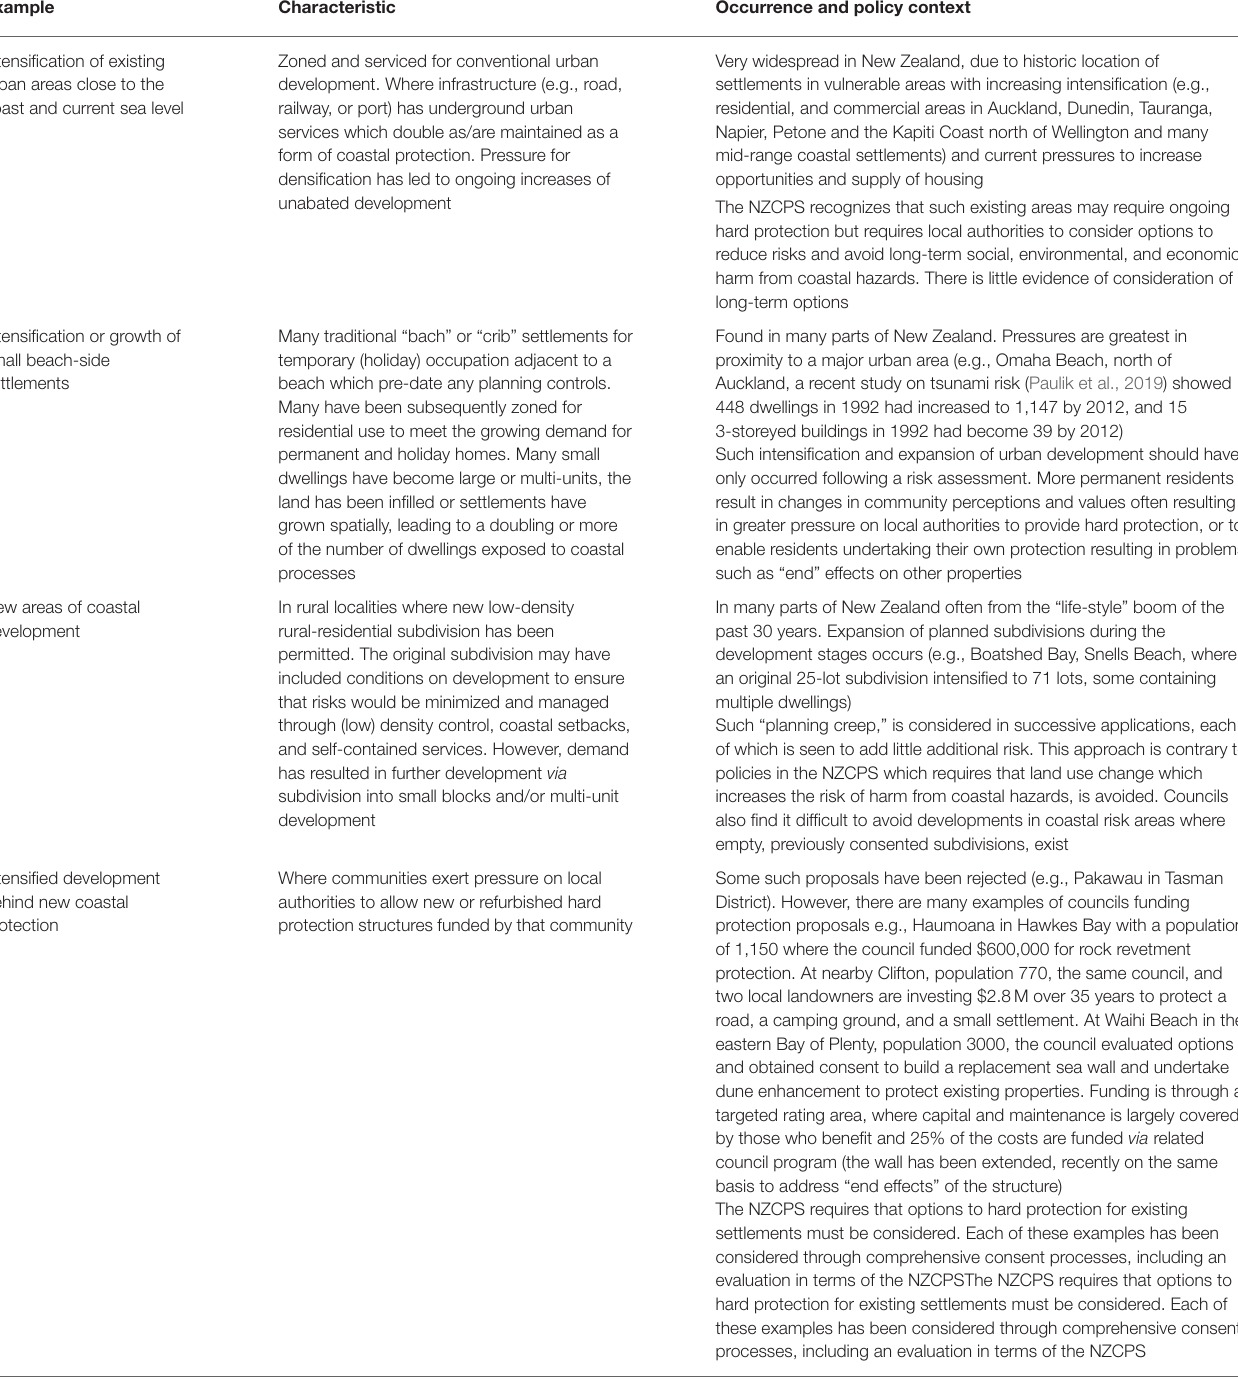
TABLE 1 | Examples of planning practice that increase vulnerability to sea-level